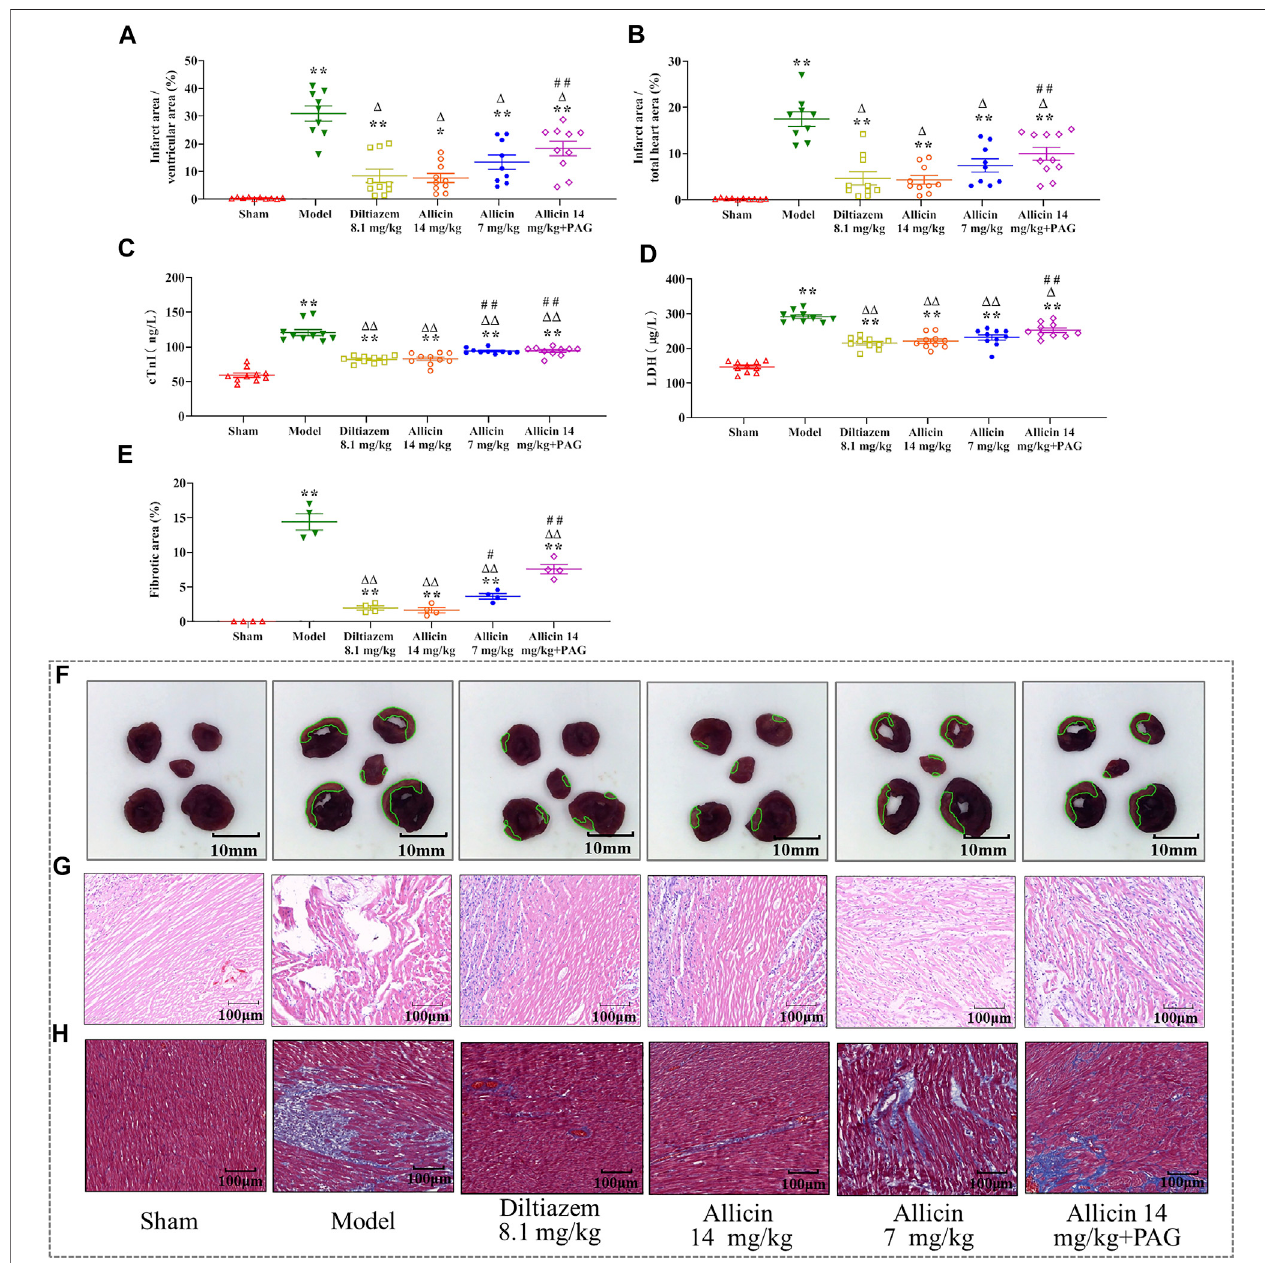
FIGURE 2 | Allicin reduced myocardial infarction area and improved morphological changes in myocardial tissue. (A,B) Percentage of myocardial infarction area overtheventricularandtotalheartarea,respectively( n (cid:1) 9 – 11). (C,D) EffectsofallicinonserumcTnIandLDHlevels( n (cid:1) 9 – 11). (E) Percentageofmyocardial fi brosisarea stained with Masson ’ s trichrome staining ( n (cid:1) 4). (F) Representative myocardial infarction areas in each group ( n (cid:1) 9 – 11). (G,H) Effects of allicin on the pathological morphologyofthemyocardiuminratswithacutemyocardialinfarctionbyH&EstainingandMassonstaining( n (cid:1) 9 – 11),magni fi cation ×